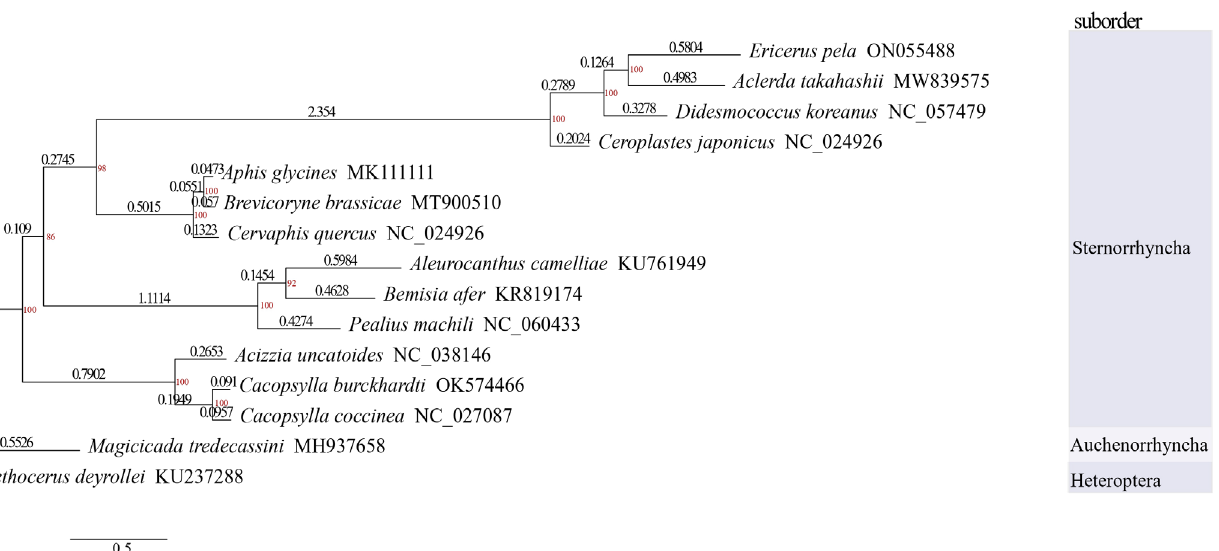
Figure 4. Secondary structures of E. pela ’s tRNAs. The specific gene name of each tRNA is stated above each secondary structure. Dashes between bases represent hydrogen bonds. ( a ) Secondary structures depicted by MITOS and ( b ) secondary structures depicted by RNA Folding Form V2.3.